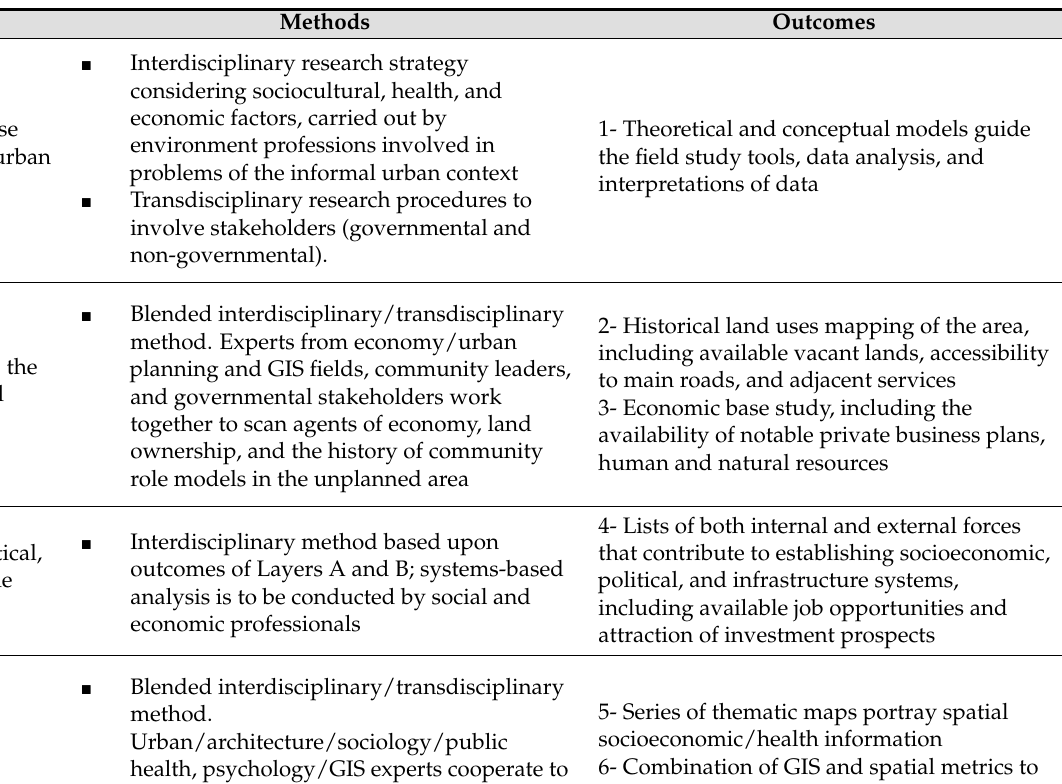
Table 2. Research schema composed of six joint